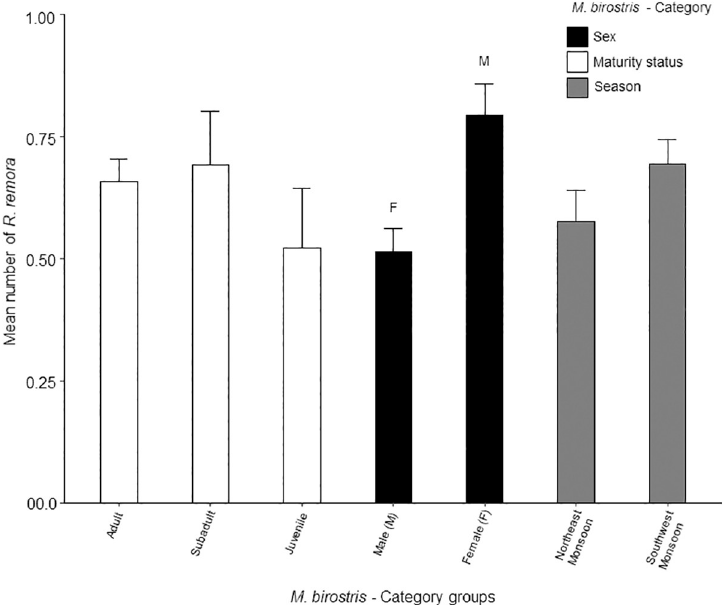
Fig 9. Daily mean number of Remora remora (+SE) observed with Mobula birostris between category groups. Each category is coloured as per legend with group name below each bar. Letters above each bar correspond to those in brackets after the group name and indicate the groups with a significant difference ( p <